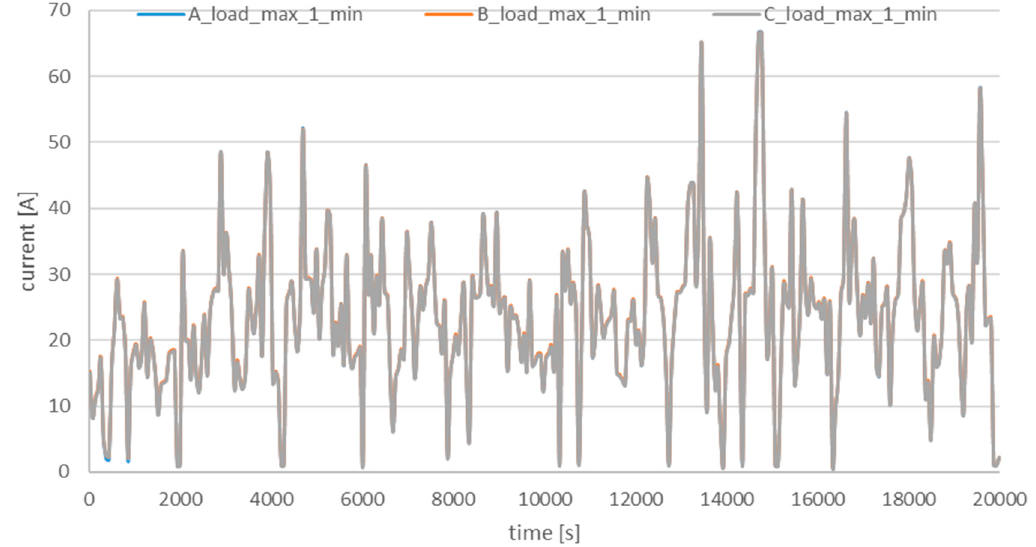
Figure 6. Measured load current (3 s measurements downsampled to maximum per 1 min). Energies 2019 , 12 , x FOR PEER REVIEW